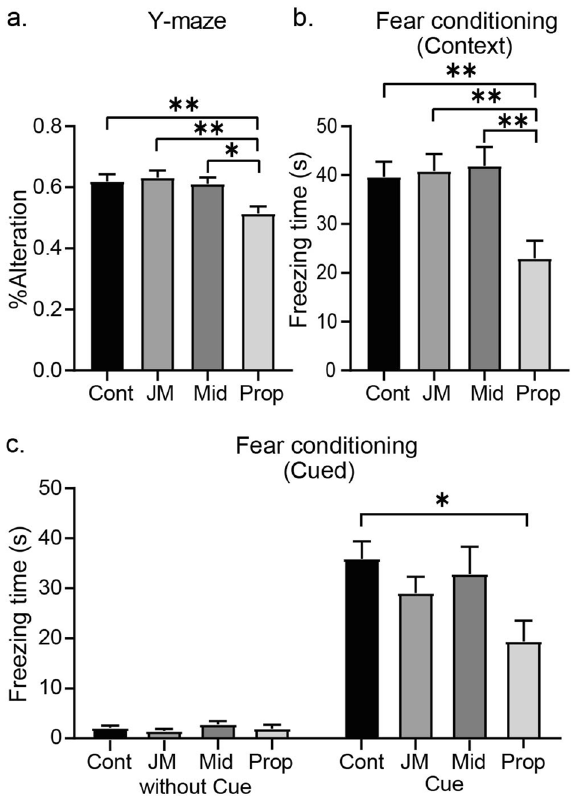
Figure 4. Neonatal administration of JM-1232(−) has no detectable long-term effects on performance on cognitive function tests. Performance of adult mice on behavioural tests of cognitive function after exposure to a single comparable dose of either JM-1232(−), propofol, or midazolam as neonates (P6). ( a ) Mean percentage of correct arm alternations in the Y-maze. Short-term spatial working memory in adulthood was significantly worse in the propofol group (n = 14) compared to that in the control group (n = 14), JM-1232(−) group (n = 14), or midazolam group (n = 13). ( b ) Mean freezing time in contextual fear conditioning. Neonatal exposure of mice to propofol but not JM-1232(−) or midazolam resulted in significantly impaired memory performance in contextual fear conditioning. Freezing response time was measured in the conditioning chamber (contextual